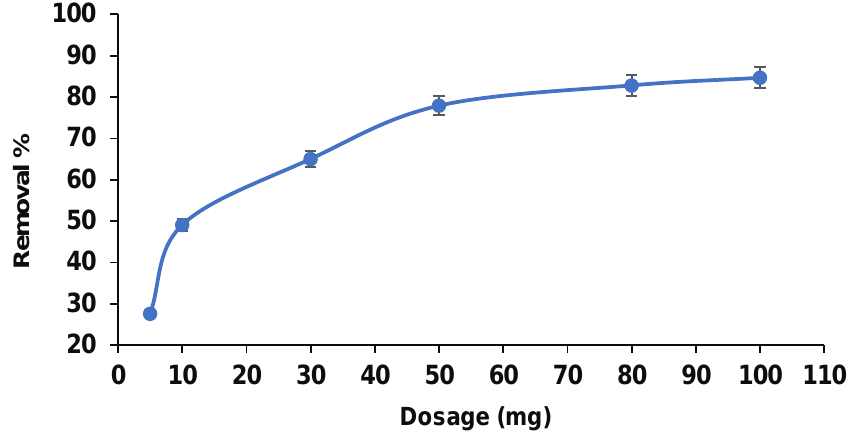
Figure 7. Effects of different amount of dosage on the removal efficiency (pH 5, 120 min reaction time, and 20 mg · L − 1 arsenic).